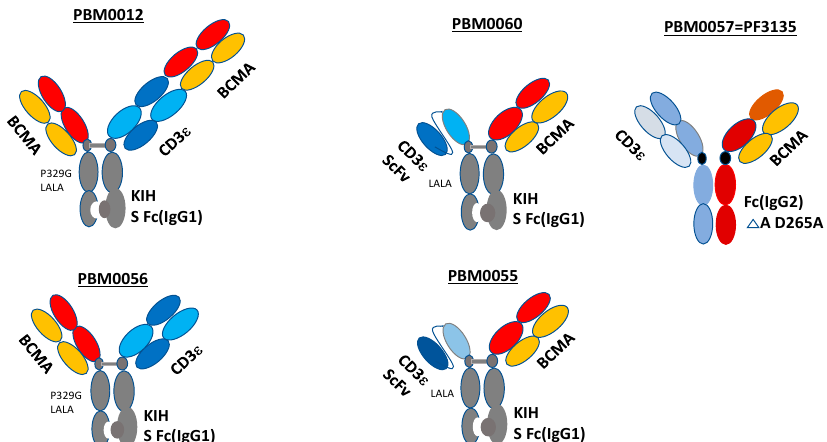
Figure 1. Different structures of BCMA-CD3 antibodies. Left panels: Bivalent PBM0012 antibody Crossmab KIH ( upper panel ) and univalent PBM0056 BCMA-CD3 CrossMAB KIH (IgG1) ( lower panel ) antibodies. Middle upper panel: BCMA-FAB-CD3 Scfv KIH, called PBM0060 (CD3 ScFv contains same heavy and light chains as for PBM0012 and PBM0056); middle lower panel: PBM0055 structure is the same as for PBM0060 antibody but with differently humanized CD3 ScFv. Right upper panel: Pfizer PF3135 control benchmark antibody, called